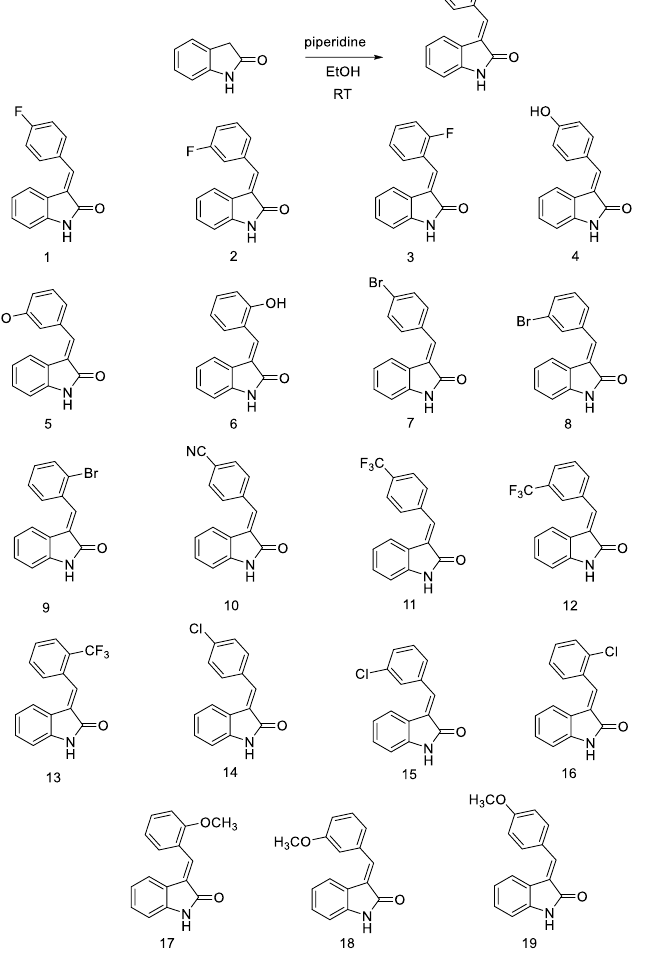
Figure 3. Synthetic scheme and structures of 3-substituted-indolin-2-one derivatives.